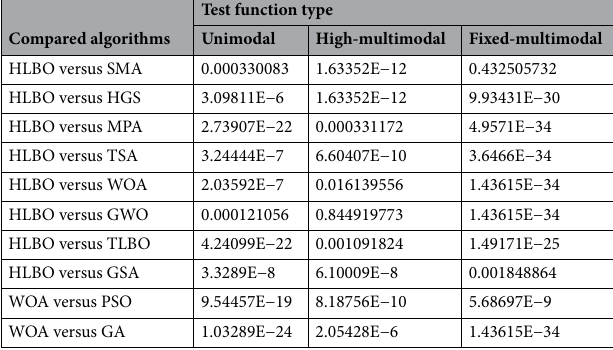
Table 5. p-values results from Wilcoxon sum rank